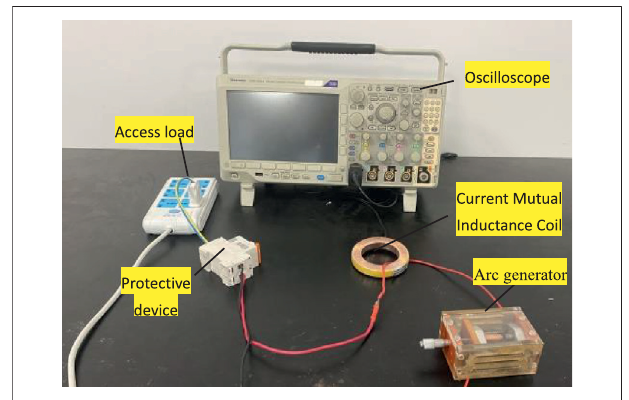
FIGURE 1 | AC series fault arc test